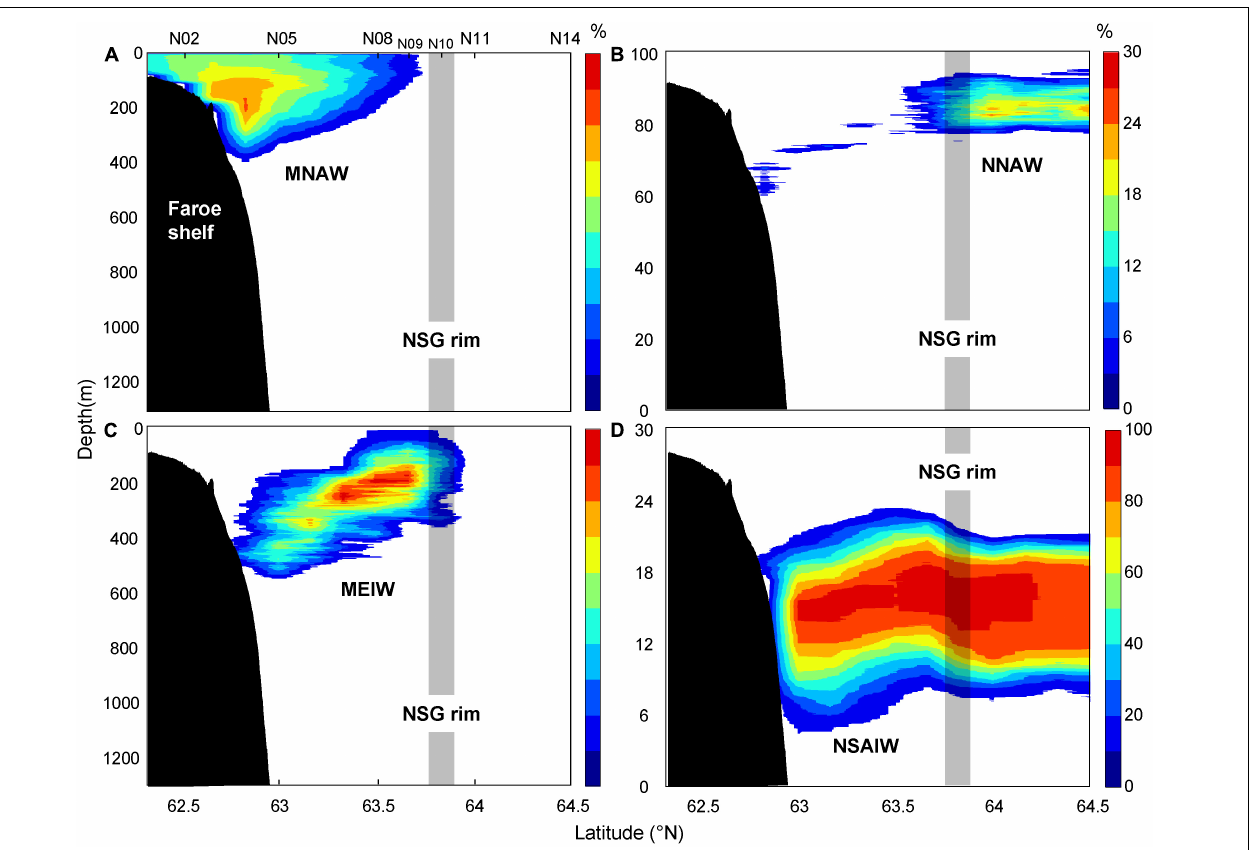
FIGURE 4 | Distribution of the main water masses at Section N (percentages of 103 complete transects between 1988 and 2019 that each latitude-depth data pixel meets the source water mass temperature and salinity criteria in Table 2 ). (A) MNAW, (B) NNAW, (C) MEIW and (D) NSAIW. Water mass abbreviations are written in full in Table 2 . The approximate location of the NSG rim is emphasized with gray bars, and the position of selected standard hydrographic stations are shown in (A)